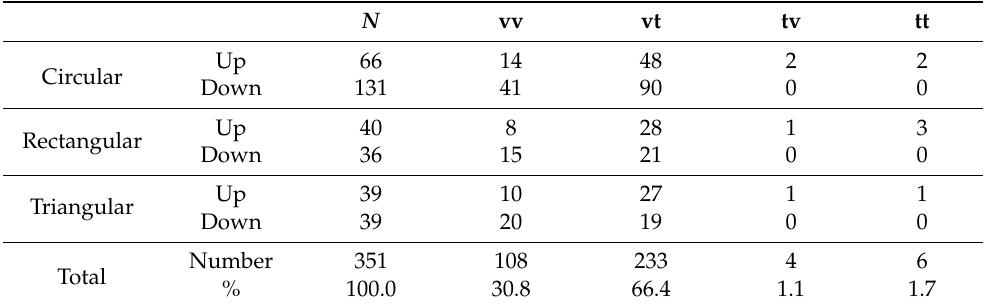
Table 2. All measured frictional pressure drop data.